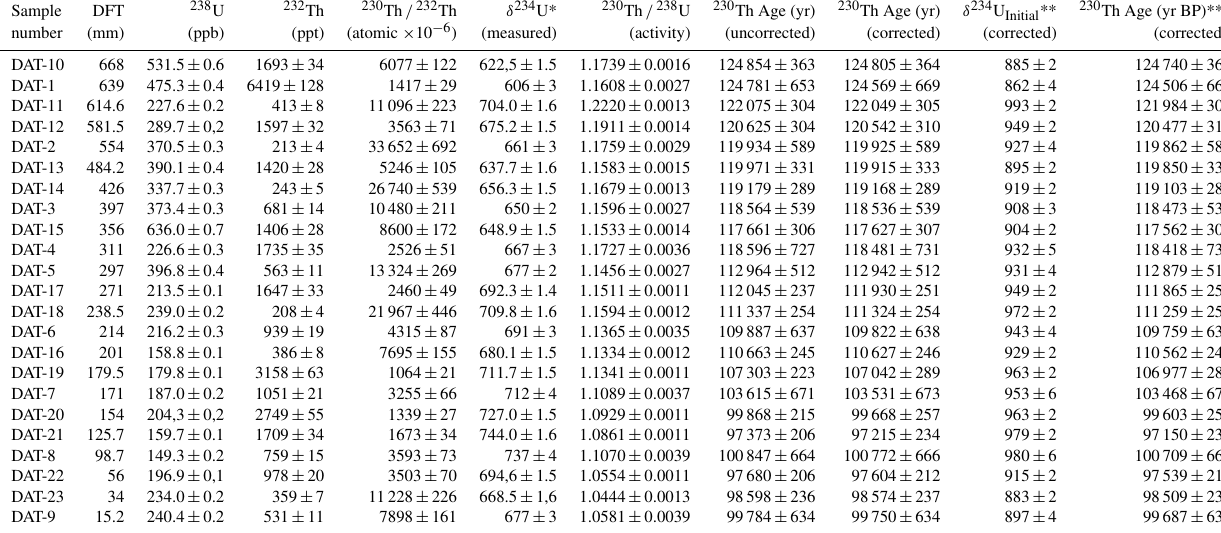
Table 1. U / Th measurements of the Han-9 stalagmite (University of Minnesota). Samples are arranged in stratigraphic order, and those in bold indicate results acquired in 2013. U decay constants: λ 238 = 1 . 55125 × 10 − 10 (Jaffey et al., 1971) and λ 234 = 2 . 82206 × 10 − 6 (Cheng et al., 2013). Th decay constant: λ 230 = 9 . 1705 × 10 − 6 (Cheng et al., 2013). Corrected 230 Th ages assume the initial 230 Th / 232 Th atomic ratio of 4 . 4 ± 2 . 2 × 10 − 6 . Those are the values for a material at secular equilibrium, with the bulk earth 232 Th / 238 U value of 3.8. The errors are arbitrarily assumed to be